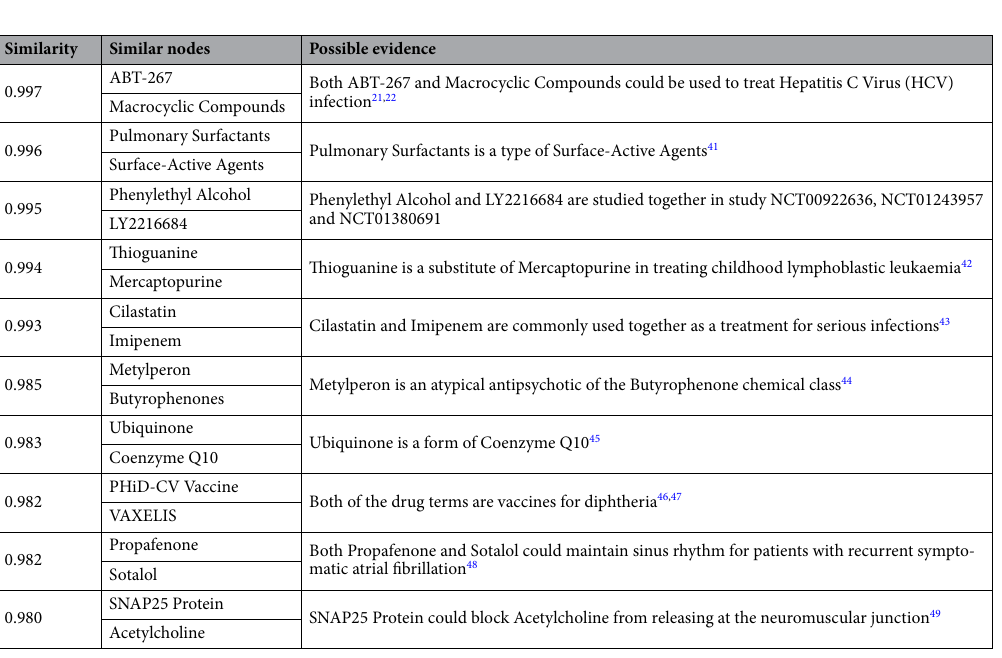
Table 6. Top-10 most similar drug-term nodes. The average cosine similarity among drug-term nodes is 0.254.